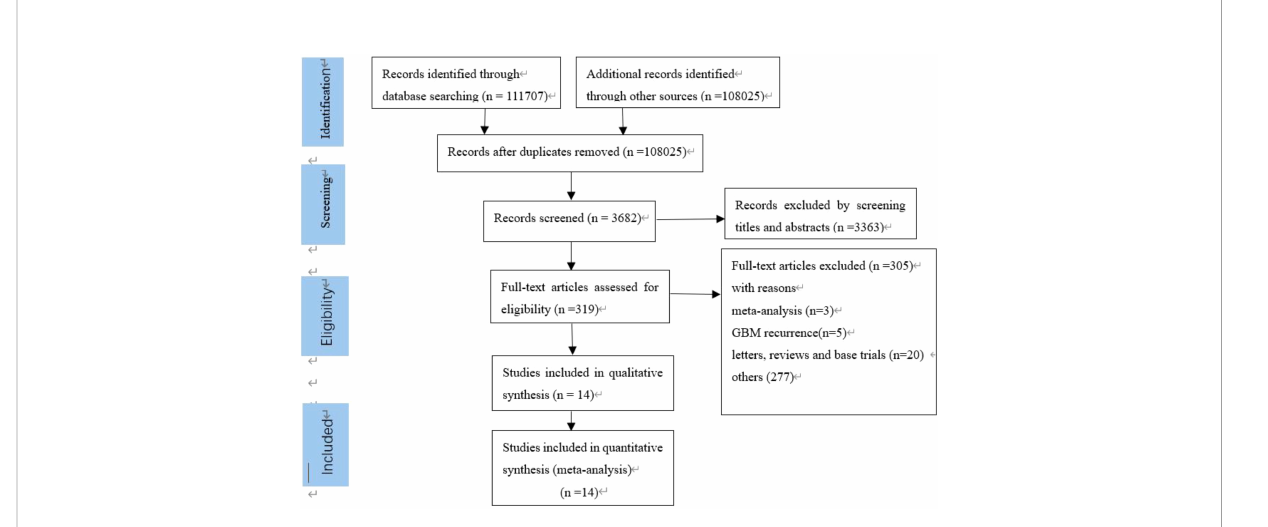
FIGURE 1 Selection process for the including